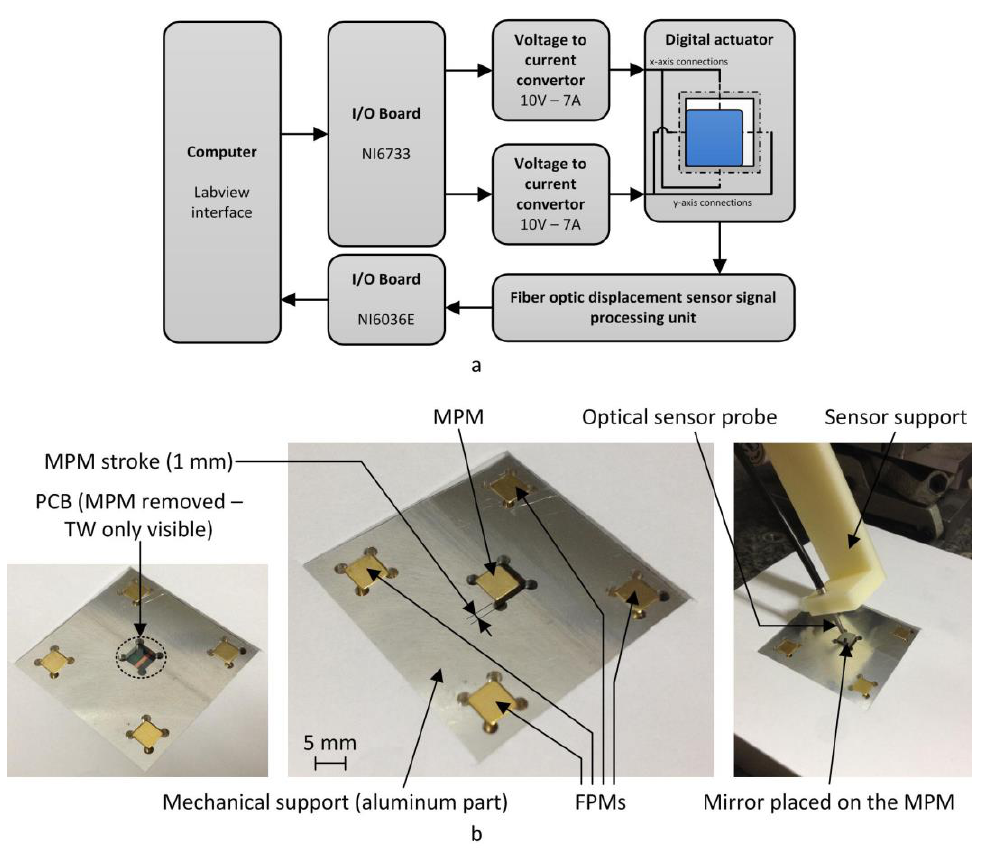
Figure 4. ( a ) Functional block diagram, ( b ) experimental